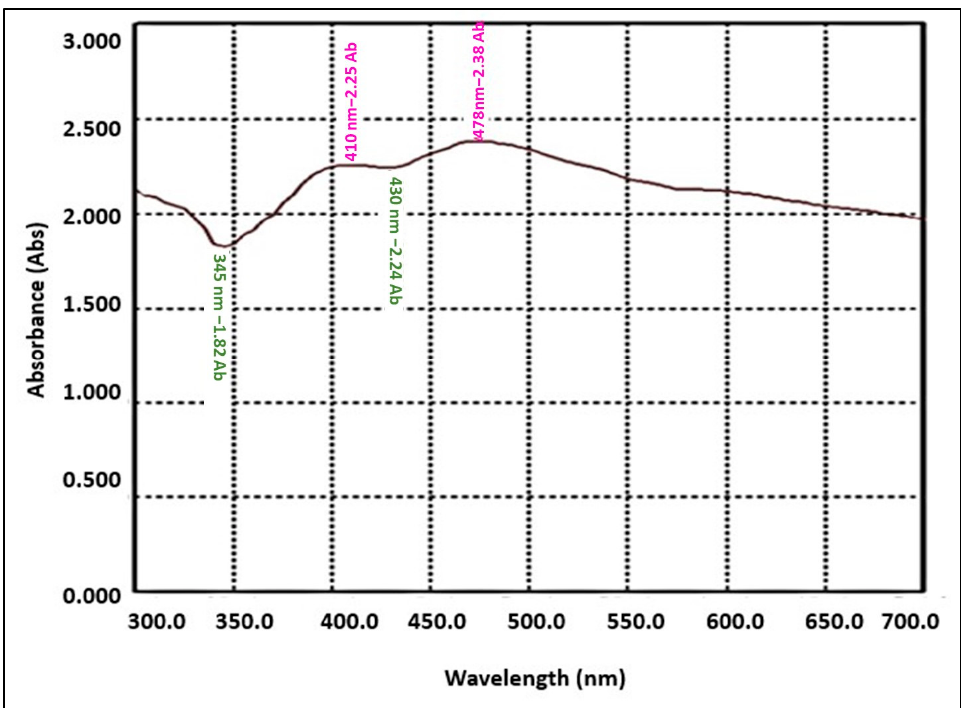
Figure 1. UV–Visible absorption spectrum of green synthesized AgNPs using M. indica aqueous leaf extract.